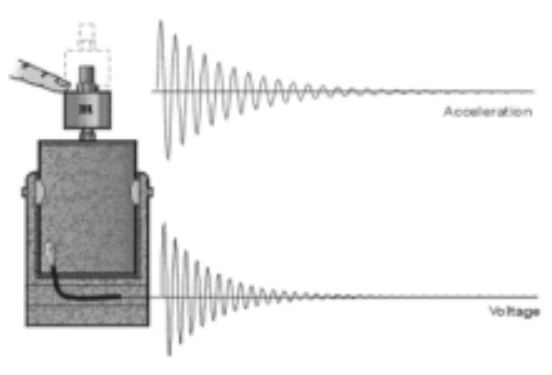
Fig. 7. Electromagnetic damping.